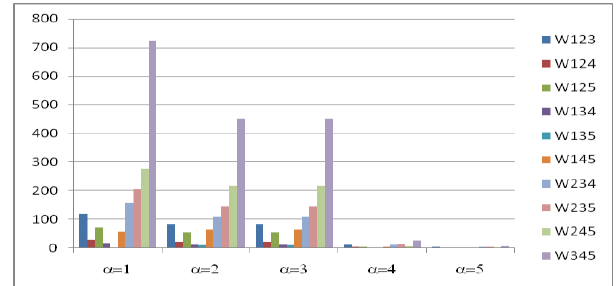
Figure 9 Number of users who are active within three windows out of five in relation to various α values